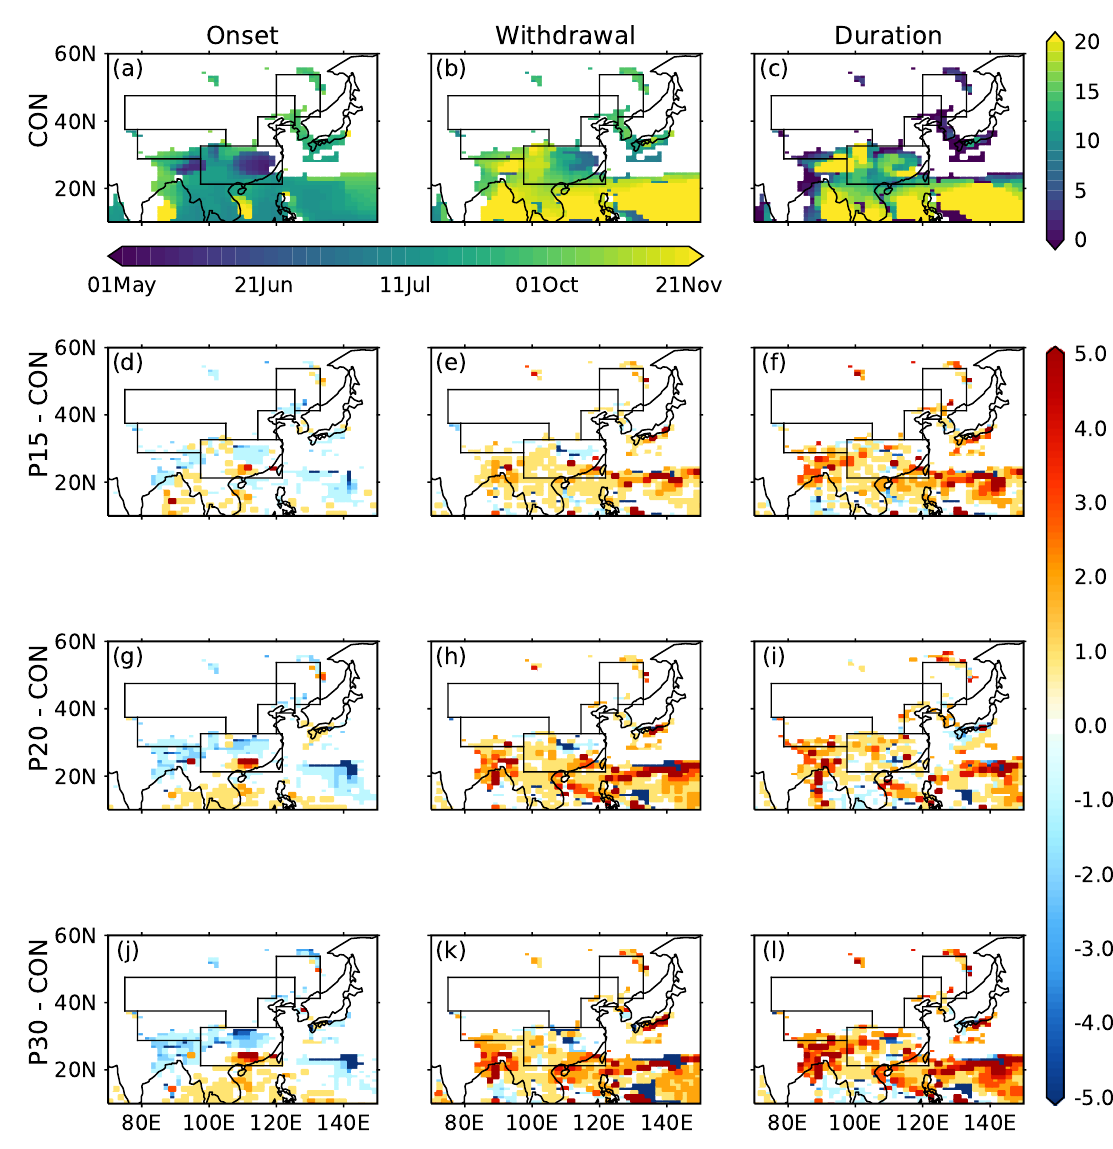
Figure 8. Ensemble-mean monsoon ( a ) onset and ( b ) withdrawal pentads (shaded) for CON with the respective colorbar below. 1st of May is the 25th pentad of the year and 21st of November is the 65th pentad of the year. The CON ( c ) duration is also shown in pentads (shaded) with the respective colorbar on the right. The respective differences for the same features between ( d – f ) P15 and CON, ( g – i ) P20 and CON and ( j – l ) P30 and CON are shown with the colorbar on the right. The blue (red) shading shows early (late) onset and withdrawal and shorter (longer) duration. The five regions are demarcated by the regional boundaries in